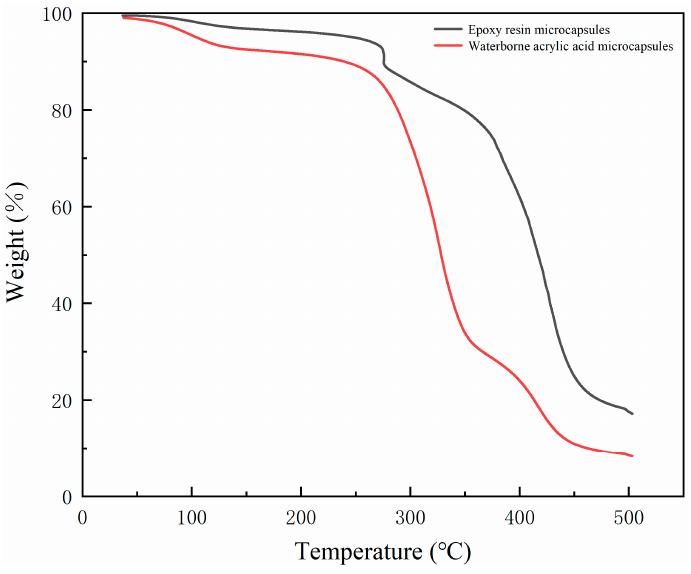
Figure 7. Thermogravimetry of waterborne acrylic microcapsules and epoxy microcapsules. Table 10. Thermal properties of waterborne acrylic acid microcapsules and epoxy resin microcapsules.